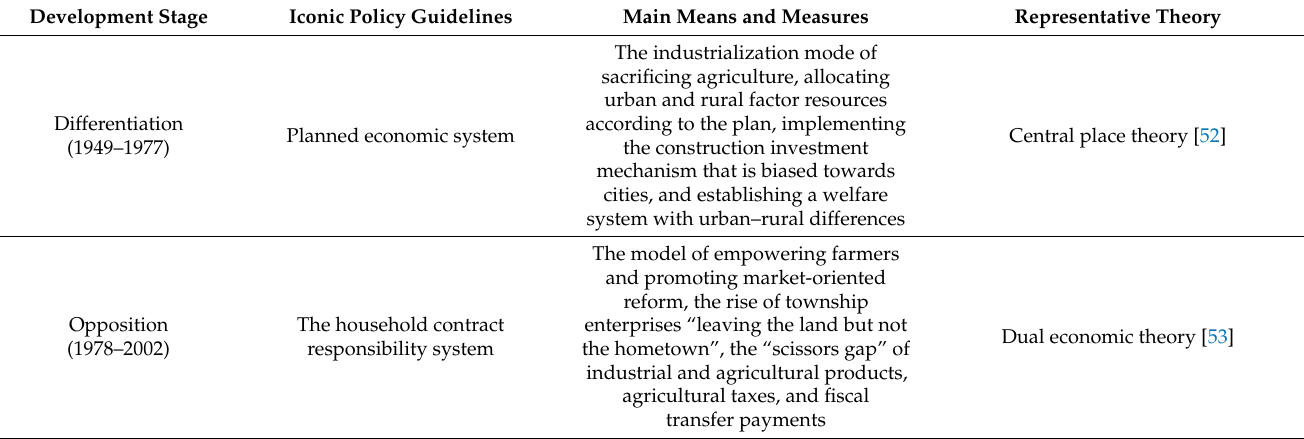
Table 1. Development stages, main measures, and theoretical support of urban–rural relations in China in